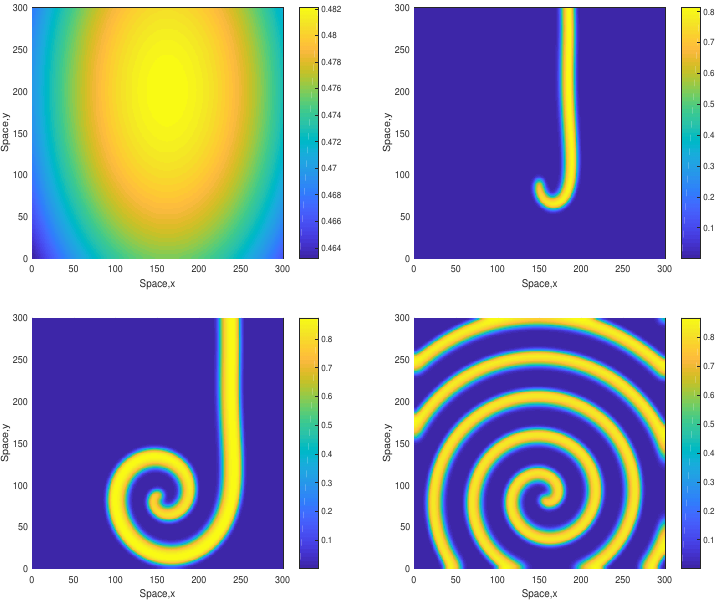
Figure 6. Spatial distribution of the oxygen concentration obtained for A = 2.7 and shown for t = 1, t = 70, t = 140 and t = 500 (left to right, top to bottom). Other parameters are the same as above. The initial conditions are given by Equations (13)–(15) with c 0 = 0.4802, u 0 = 0.3206 and v 0 = 0.1658.